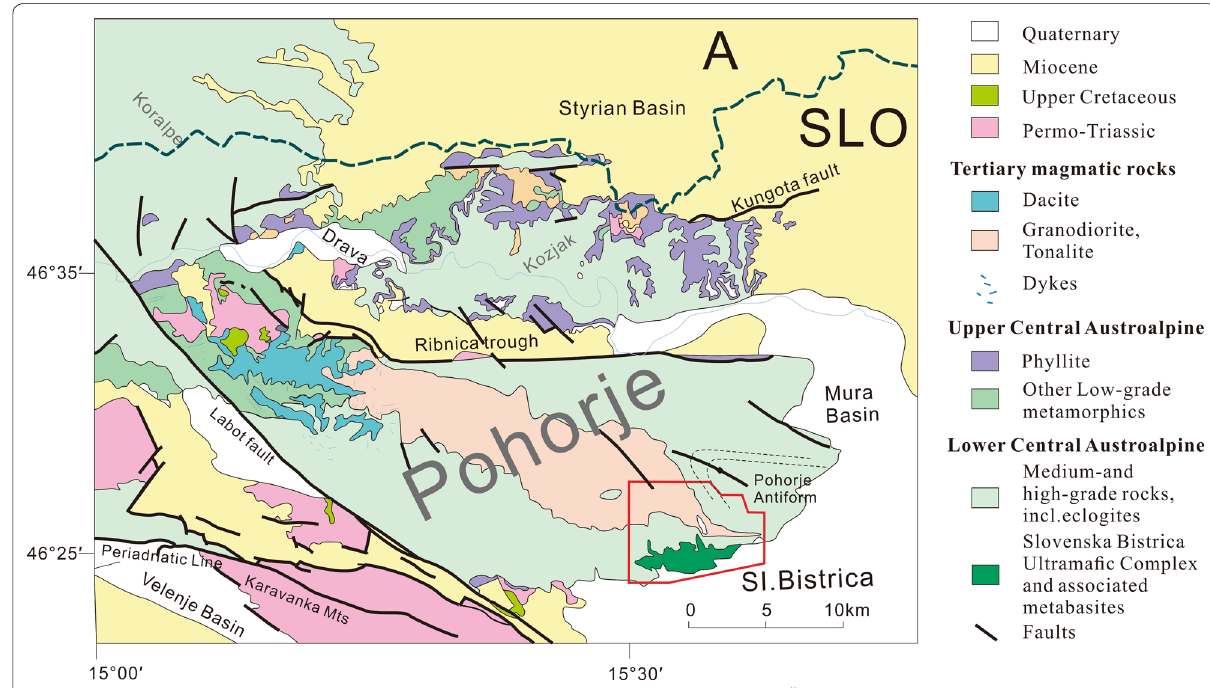
Fig. 2 Geological map of the southeastern Alps with the Pohorje Mts (modified from Mioč and Žnidarčič 1977). Location of detailed map of Fig. 3 is shown,